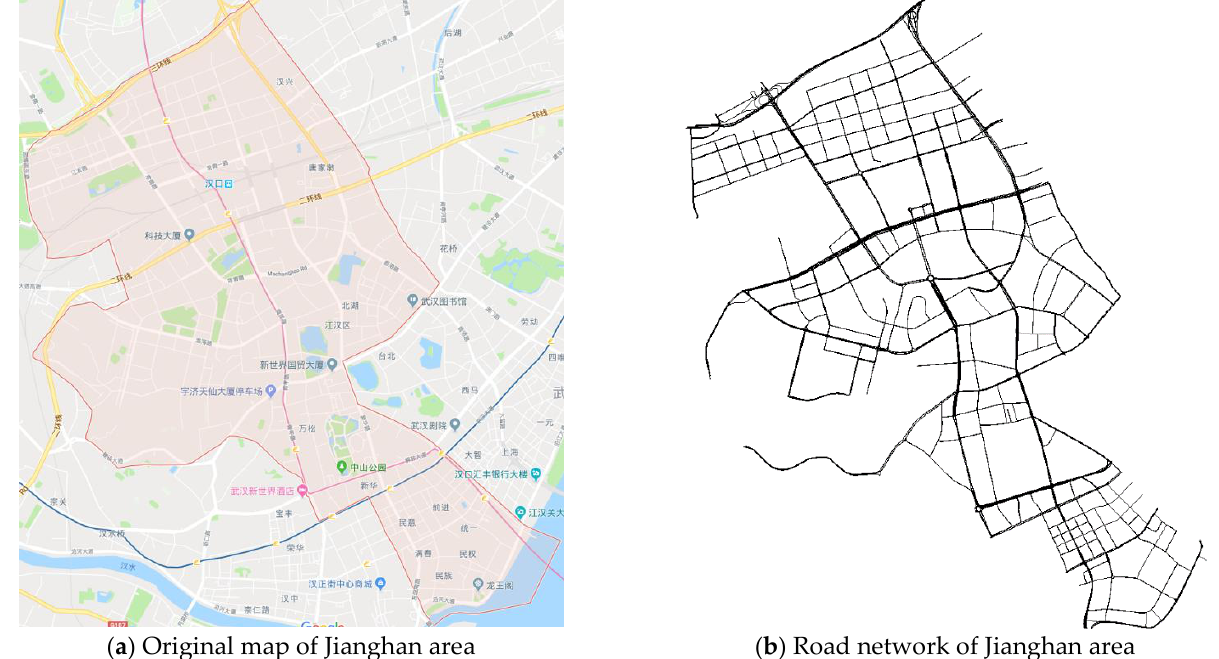
Figure 2. ( a ) Original Map and ( b ) abstracted road network of Jianghan